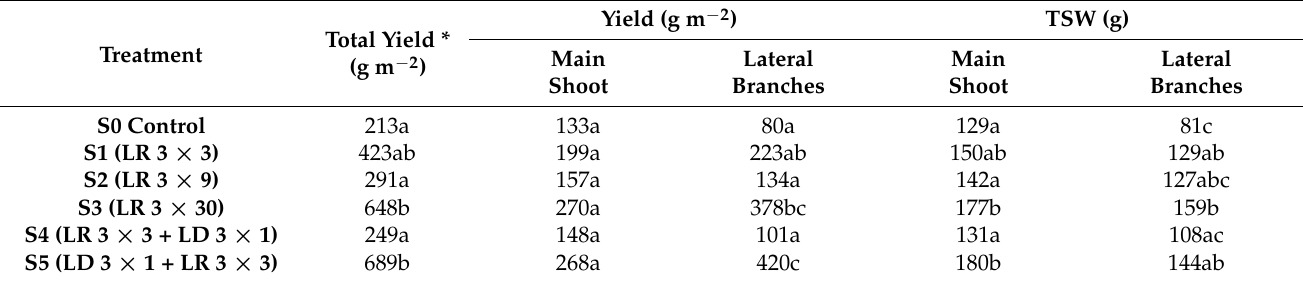
Table 2. Yields of soybean plants.